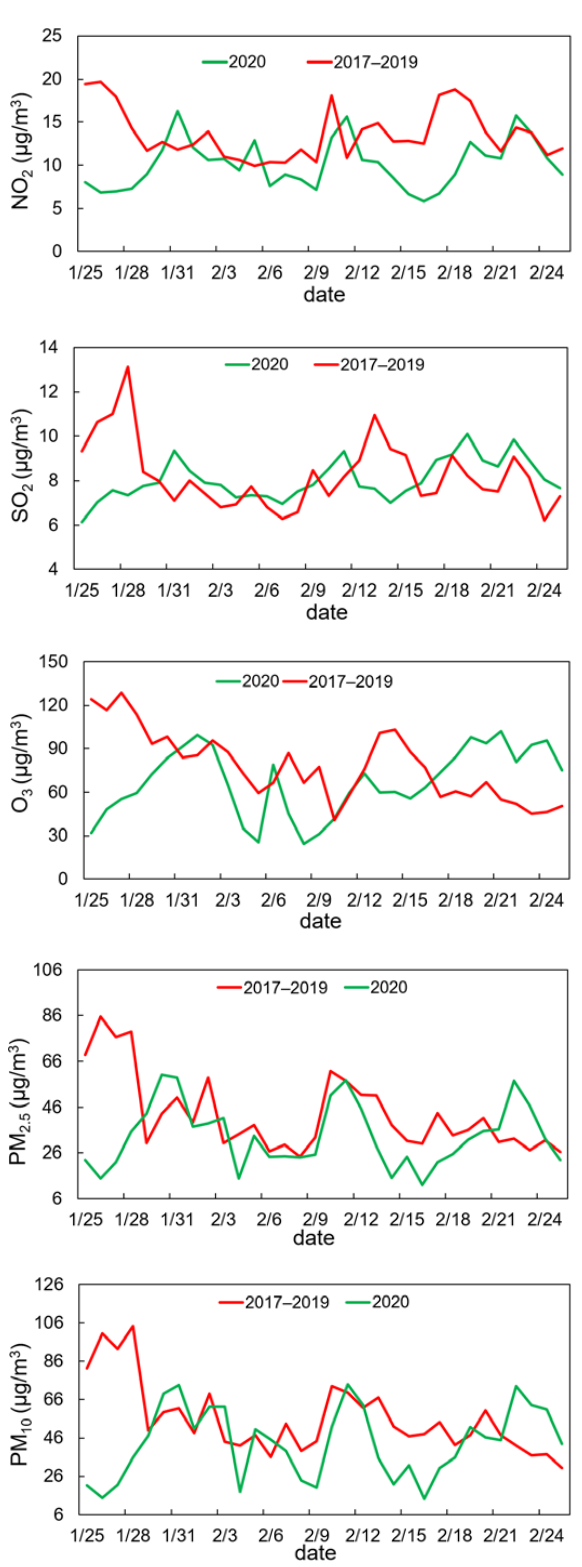
Figure 5. Daily NO 2 , SO 2 , O 3 , PM 10 and PM 2.5 mean concentrations of all four stations in Beihai between 25 January and 25 February averaged over the previous three years (2017–2019, red line) and in 2020 (the COVID-19